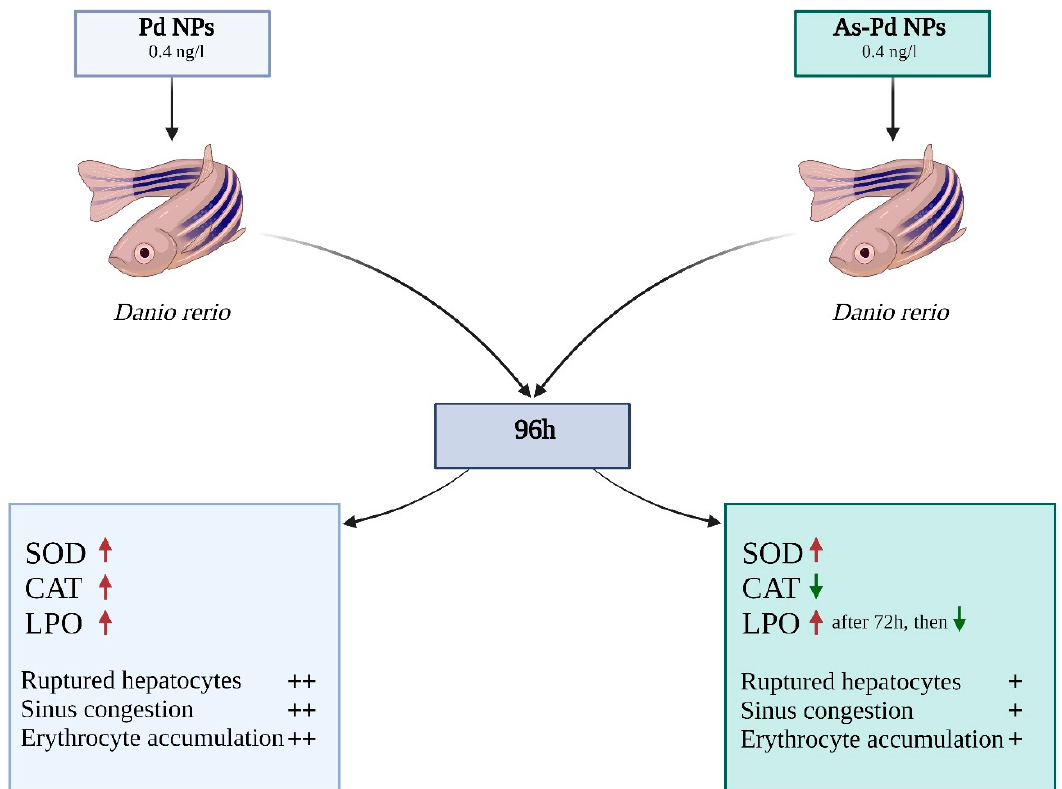
Figure 4. Comparison of the toxicity of palladium nanoparticles (Created with BioRender.com accessed on 29 July 2022).